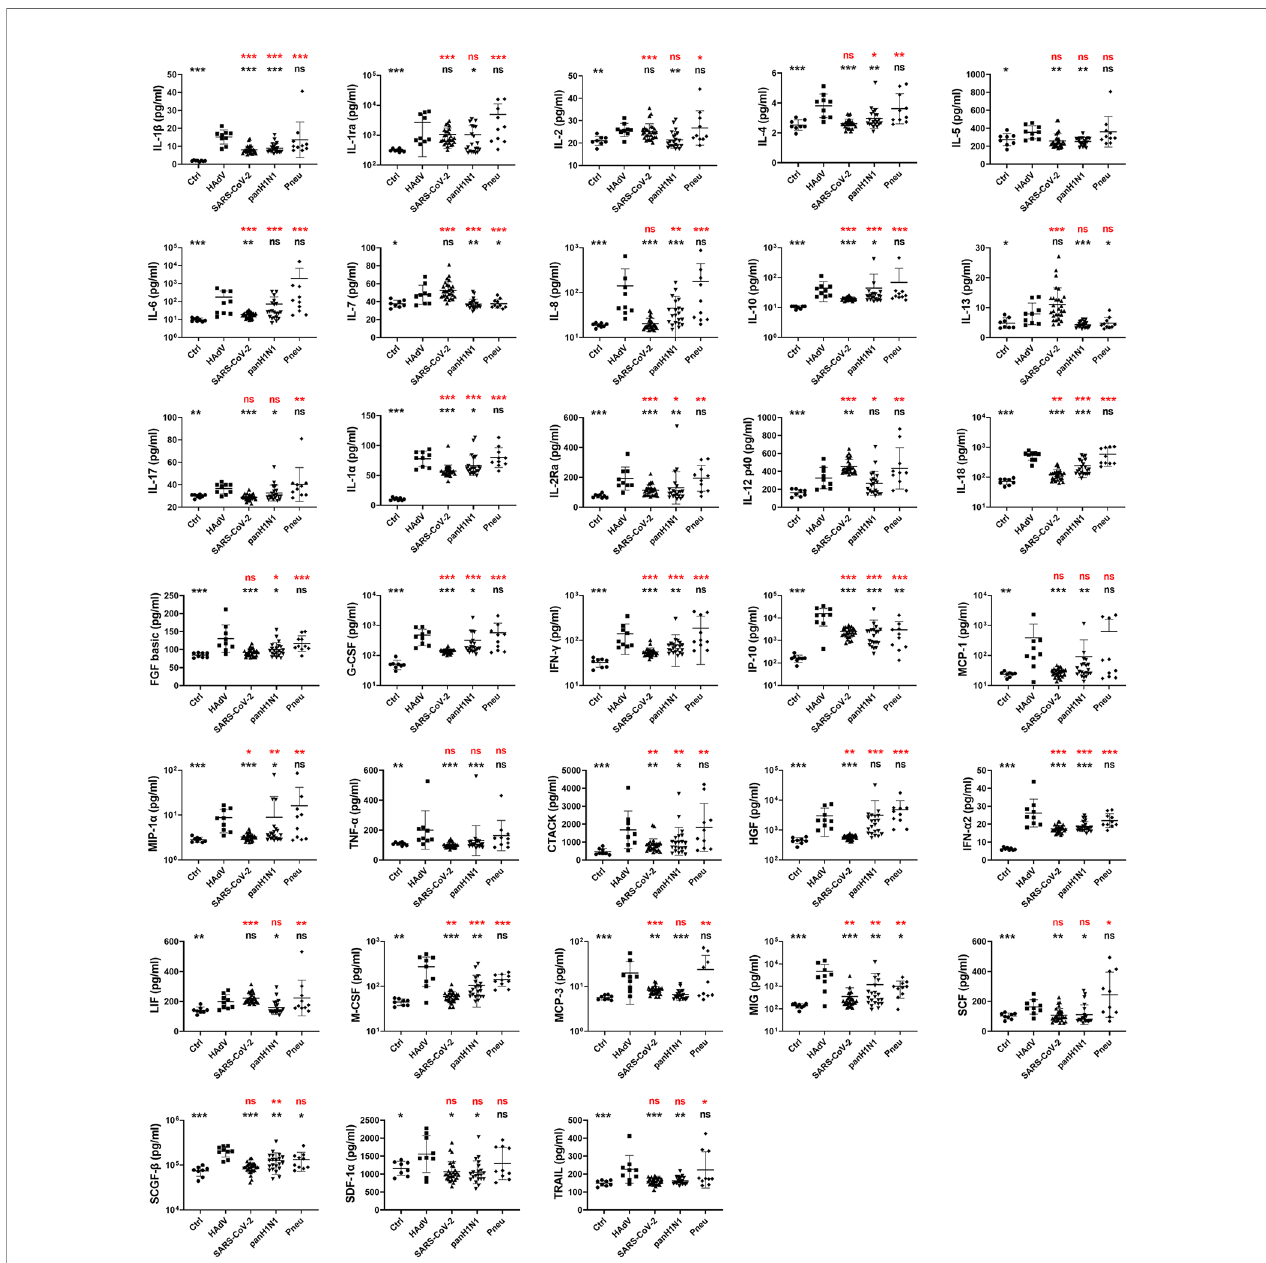
FIGURE 1 | Comparison of cytokines/chemokines expression pro fi les among patients infected with HAdV, SARS-CoV-2, panH1N1 or bacteria complicated with ARDS upon admission. Samples from patients infected with HAdV (n = 9), SARS-CoV-2 (n = 28) and panH1N1 (n = 21) were collected at the earliest possible time- point after hospitalization and subjected to cytokines/chemokines measurement. Healthy controls (n = 8) and patients with bacterial pneumonia (n = 10) were included as controls. Results of 33 cytokines/chemokines showing signi fi cantly increased expression in the HAdV group are shown. Statistical analyses with the reference group of HAdV and HCs are shown in black and red, respectively. P = 0.01 – 0.05, 0.001 – 0.01 and <0.001 was considered signi fi cant (*), very signi fi cant (**) and extremely signi fi cant (***), respectively, whereas ns represents not signi fi